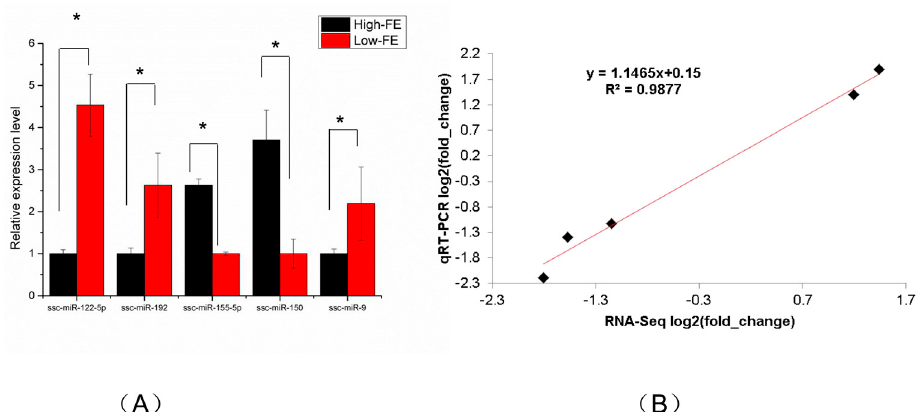
Figure 4. Validation of the RNA sequencing using qRT-PCR. U6 snRNA was used for samples standardization. ( A ) qRT-PCR validation of five DEMs in adipose tissues. ( B ) Line-fit plot of qRT-PCR results and RNA-sequencing data for selected DEMs. Mark * in ( A ) represent the expression level significantly different between two group ( p < 0.05).